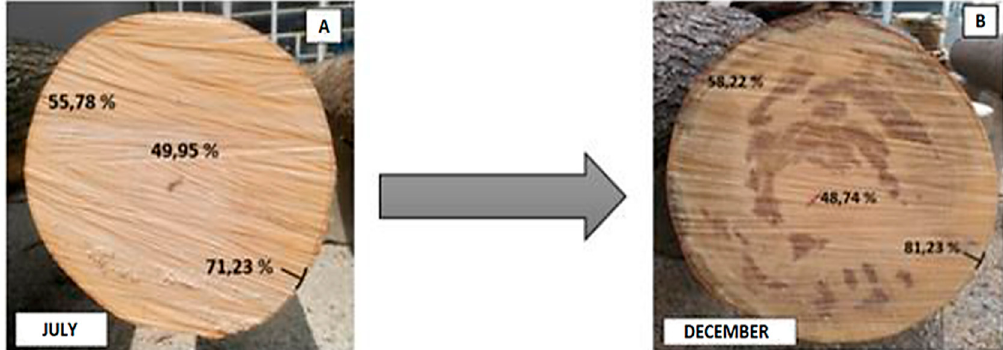
Figure 5. The moisture distribution ( A ) at the beginning of storage and ( B ) after six months of storage in the case of the beech logs .